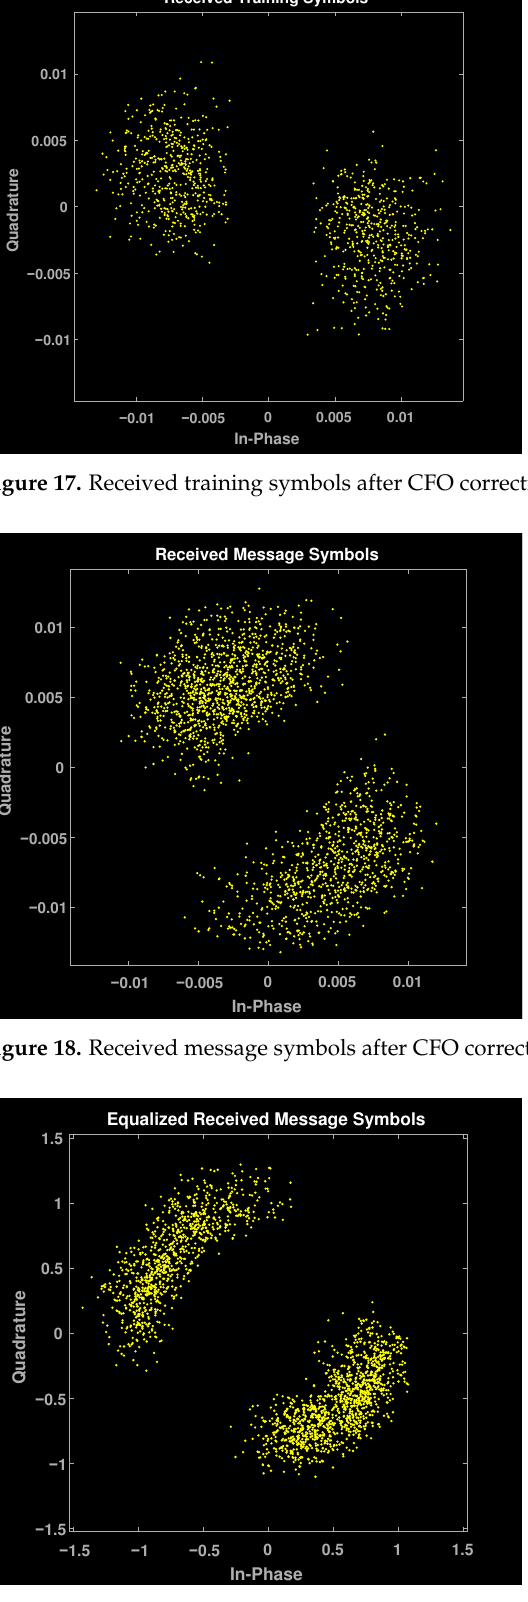
Figure 19. Received message symbols after CFO correction and